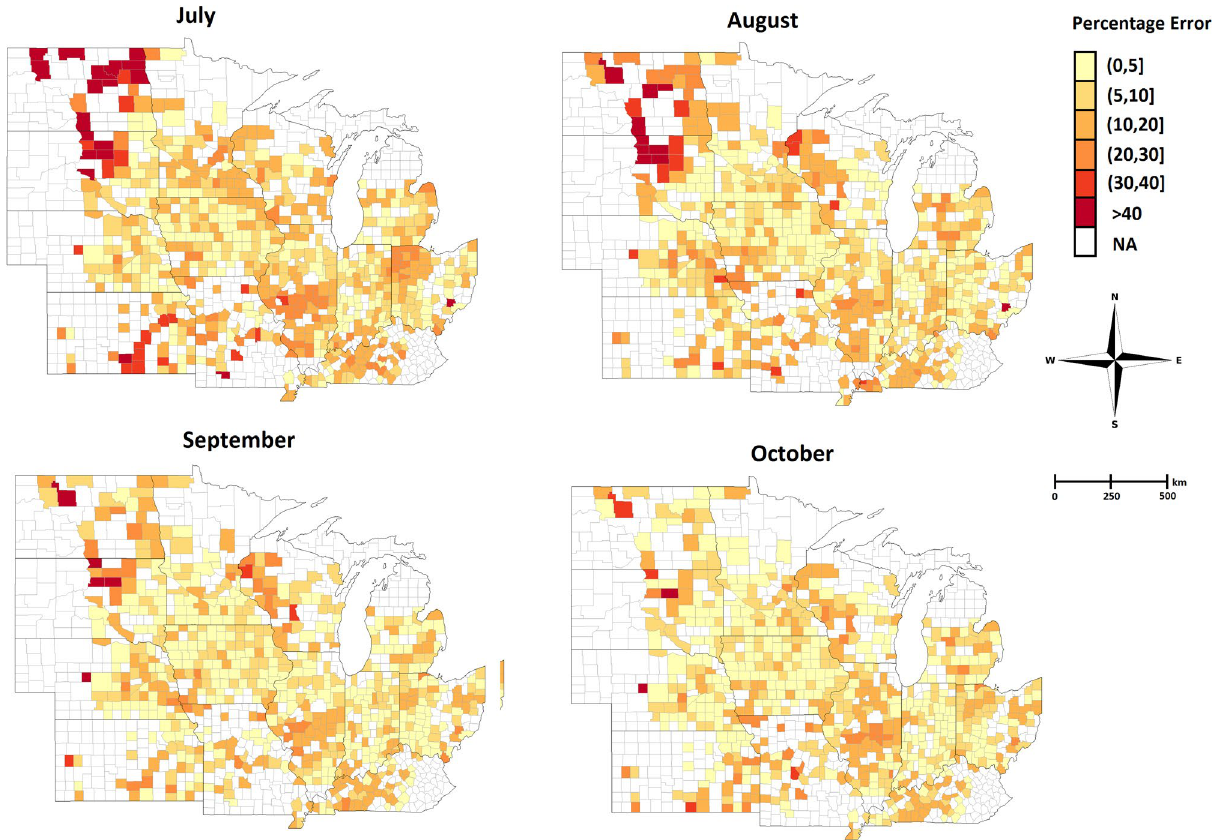
Figure 6. The error percentage maps for the 2018 soybean yield prediction which is done during the growing season in July, August, September, and October. The counties with white color indicate the ground truth yield were not available for those counties in 2018.